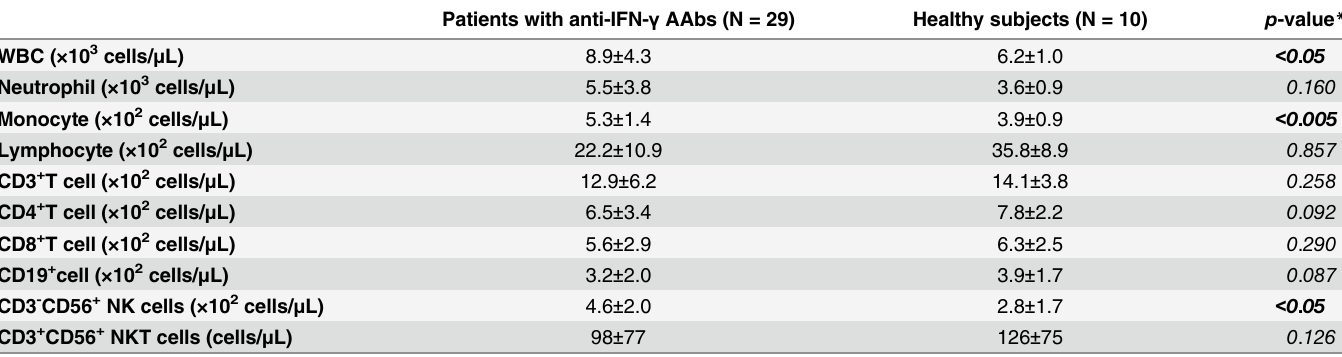
Table 1. Leukocyte Distribution in the patients with anti-IFN- γ Autoantibodies and Healthy Subjects. Patients with anti-IFN- γ AAbs (N = 29) Healthy subjects (N =